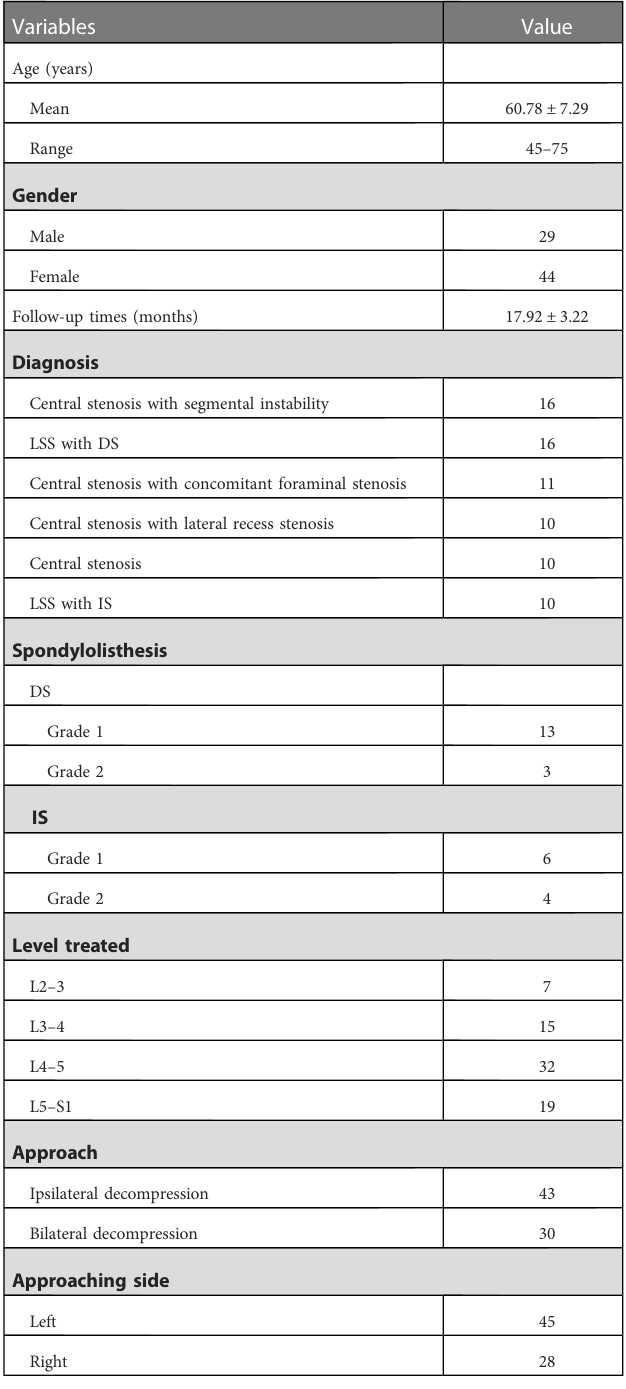
TABLE 2 Results related to UBE-TLIF.